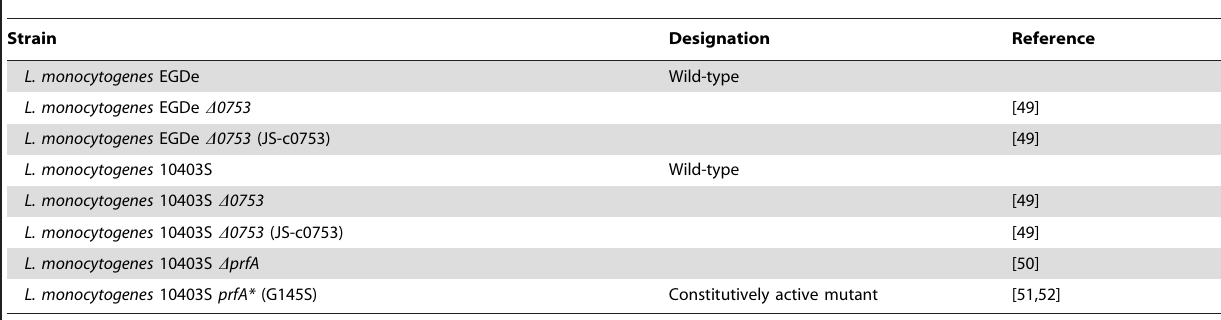
Table 1. Bacterial strains used in this